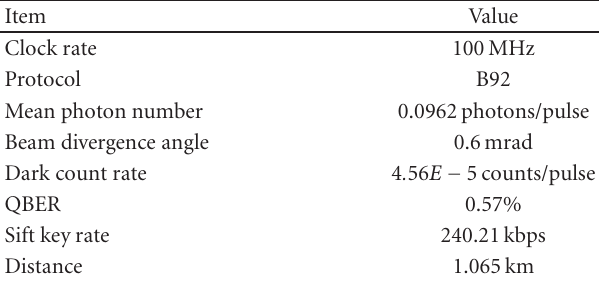
Table 1: Parameters used in the 1-km QKD